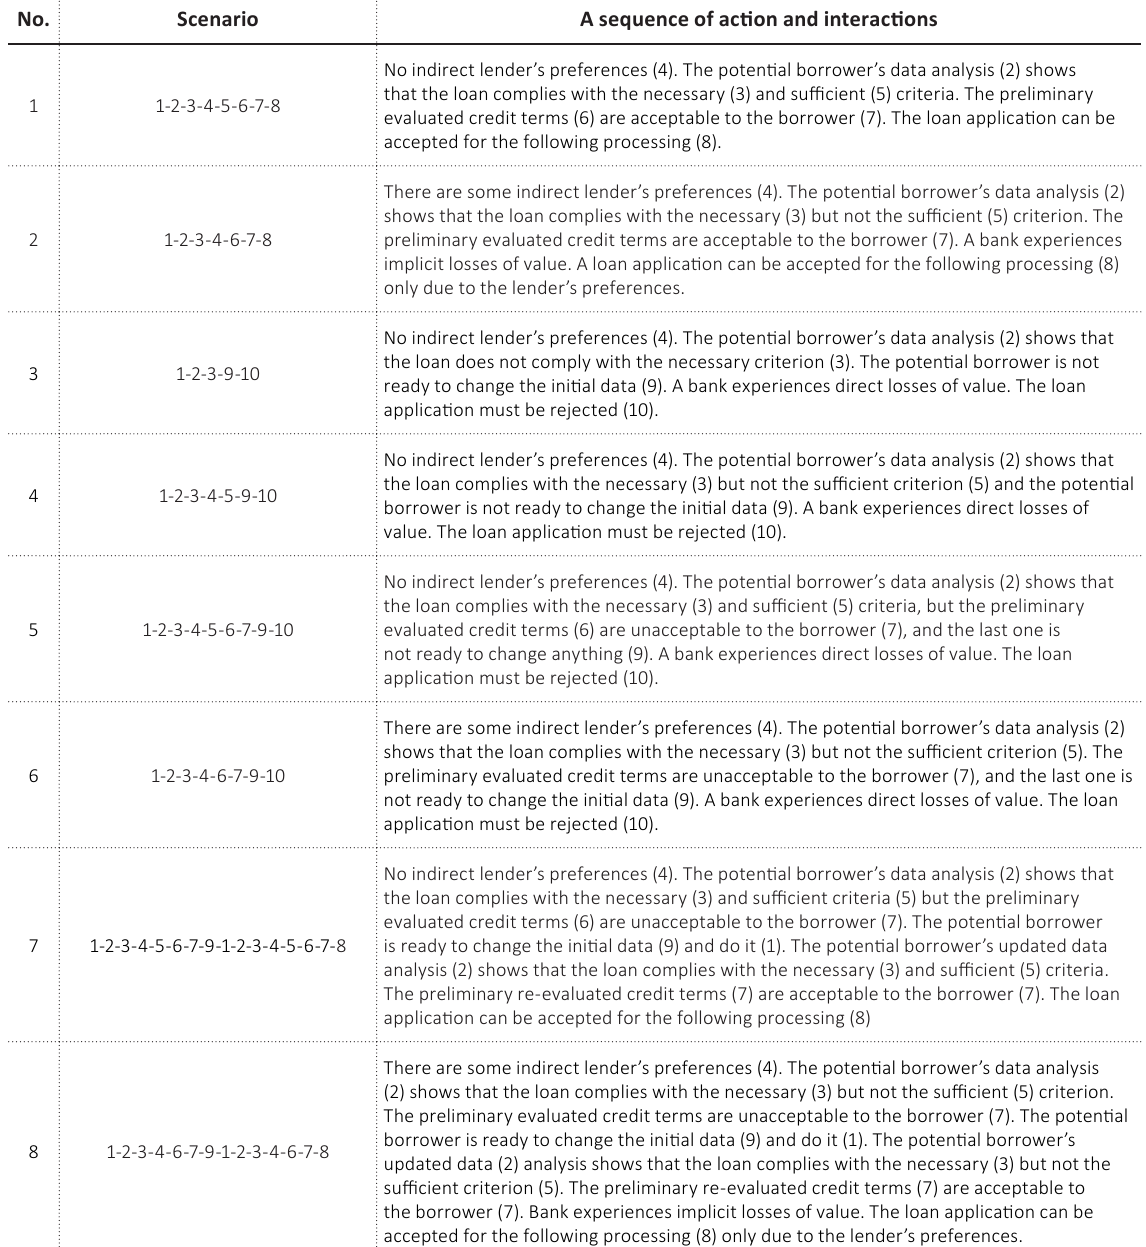
Table 2. Selected scenarios for the realization of the algorithm No.